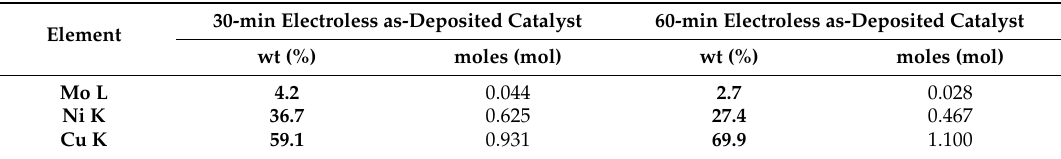
Table 3. Weight percentages and moles of Cu, Ni and Mo of the 30-min and 60-min electroless as-deposited CuNiMoP/Al 2 O 3 catalysts.